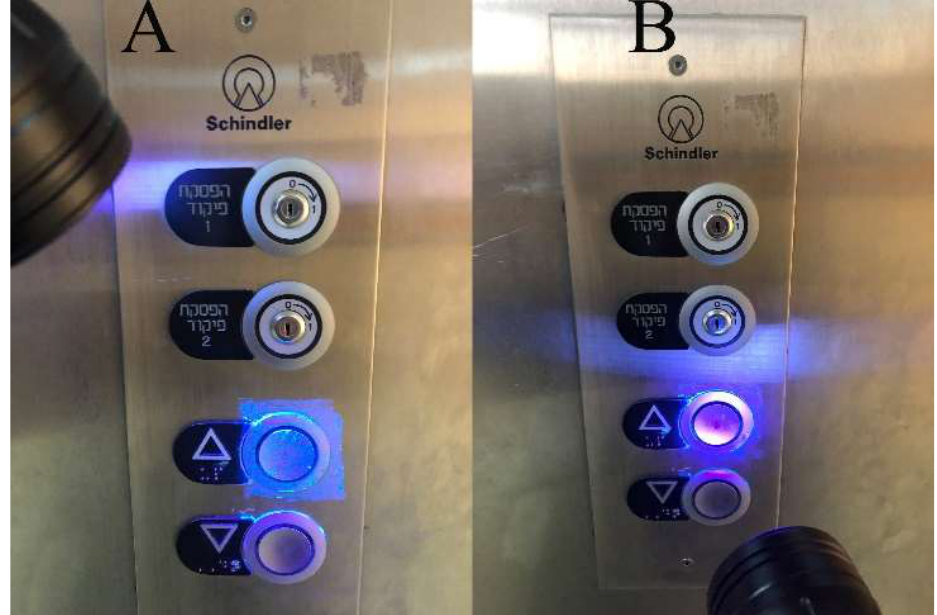
Figure 2. Application of FM to elevator bu(cid:308)ons; ( A ): Elevator bu(cid:308)ons following FM application; ( B ): elevator bu(cid:308)ons 24 h post-application (scored as unclean).